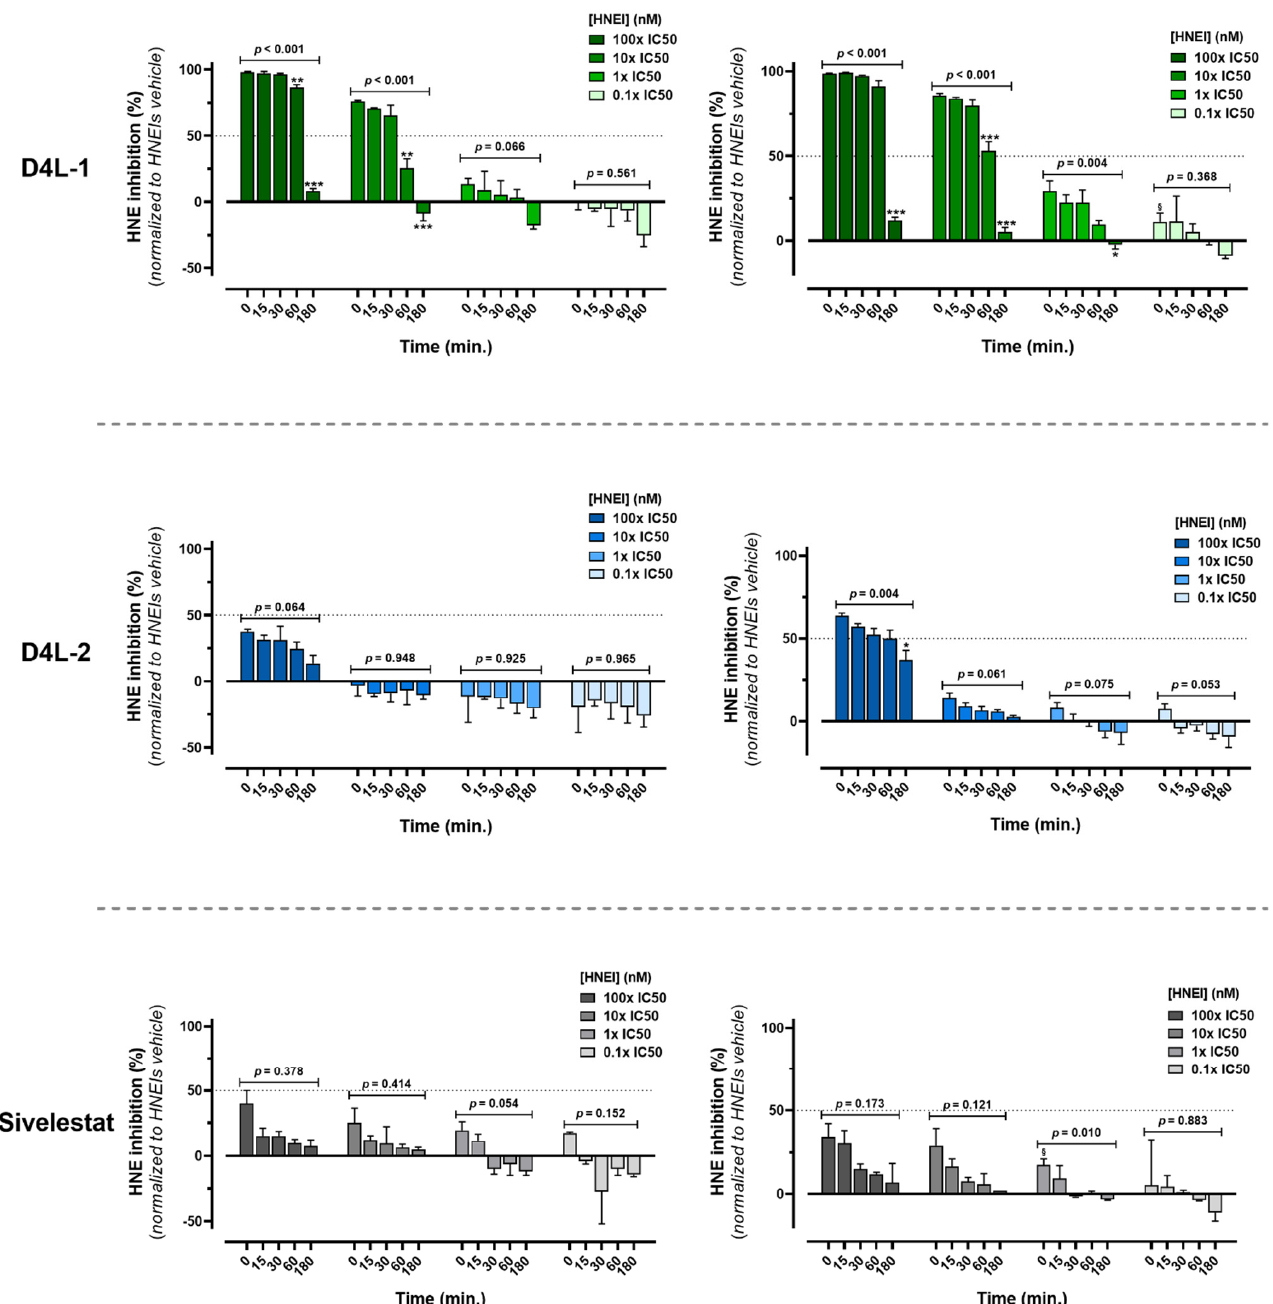
Figure 1. Human neutrophil elastase (HNE) inhibition of D4L-1, D4L-2, and Sivelestat when incubated with plasma (left side) or diluted plasma (right side), assessed by the HNE activity assay after incubations of 0, 15, 30, 60, and 180 min at 37 °C. Data obtained from at least 3 independent experiments (performed in triplicate) are presented as mean ± SEM (standard error of the mean). Dotted line represents the IC50 value of the respective HNEI. Brackets denote the statistical analysis results of time of incubation comparison for the respective solution concentration of each HNEI (one-way ANOVA test), * p <0.05, ** p <0.01, *** p <0.001 between that time point and all the preceding time points, § p <0.05 between 0 min and 60/180 min (Bonferroni post hoc test); p < 0.05 was considered statistically significant. For each assay, HNE inhibition was standardized establishing that HNEIs’ vehicle (0.125% DMSO) samples corresponded to zero (minimum). HNEI, human neutrophil elastase inhibitor; IC50, half maximal inhibitory concentration. When incubated in plasma, D4L-1 at 0.1× IC50 showed no inhibitory capacity at any time point, which was also null for 10× IC50 and 1× IC50 at 180 min; when incubated in